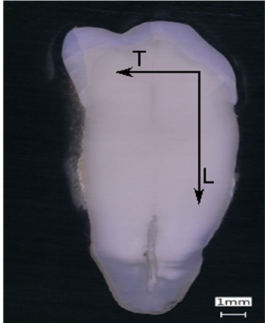
Figure 1. Representation of the prepared dentin surface on a human donor tooth indicating the two measuring directions for the transversal (T) and longitudinal (L) roughness